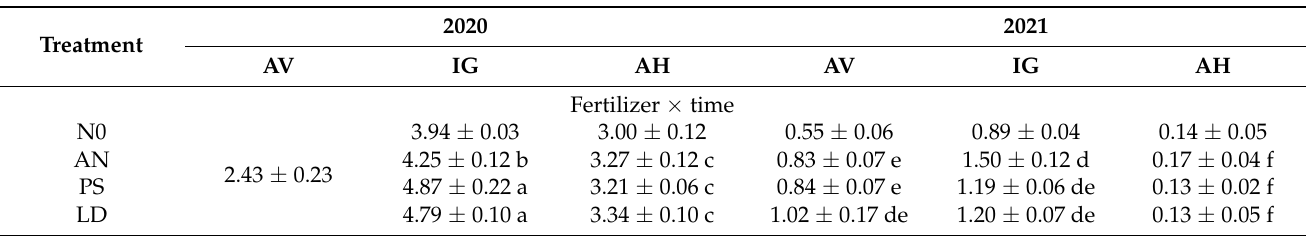
Table 4. Soil ammonium nitrogen (N-NH 4 ) variation during winter wheat growing season in mg · kg − 1 (0–60